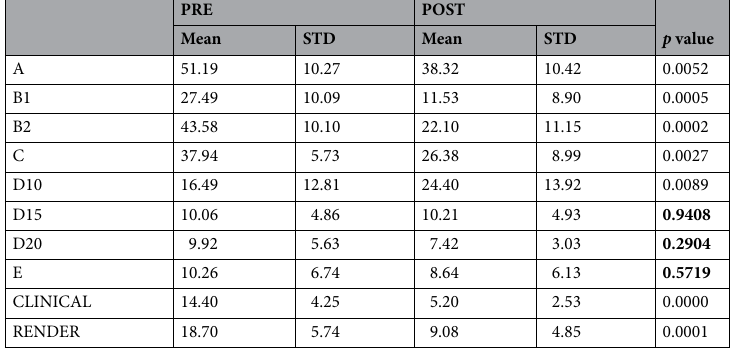
Table 1. Mean and standard deviation (STD) of the HAA measurements (unit is degrees) over all the patients for each of the different CBCT-based techniques and for the two based on the external aspect and a goniometer (CLINICAL, RENDER). This is reported for the pre-op and the post-op condition, along with the p values for the difference between these two conditions (values not statistically significant in bold).